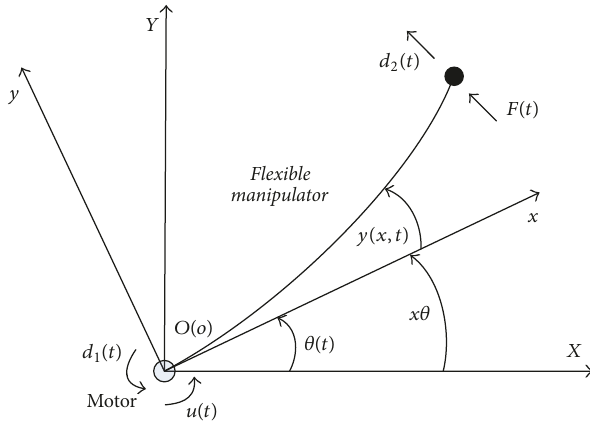
Figure 1: Configuration of a flexible manipulator.